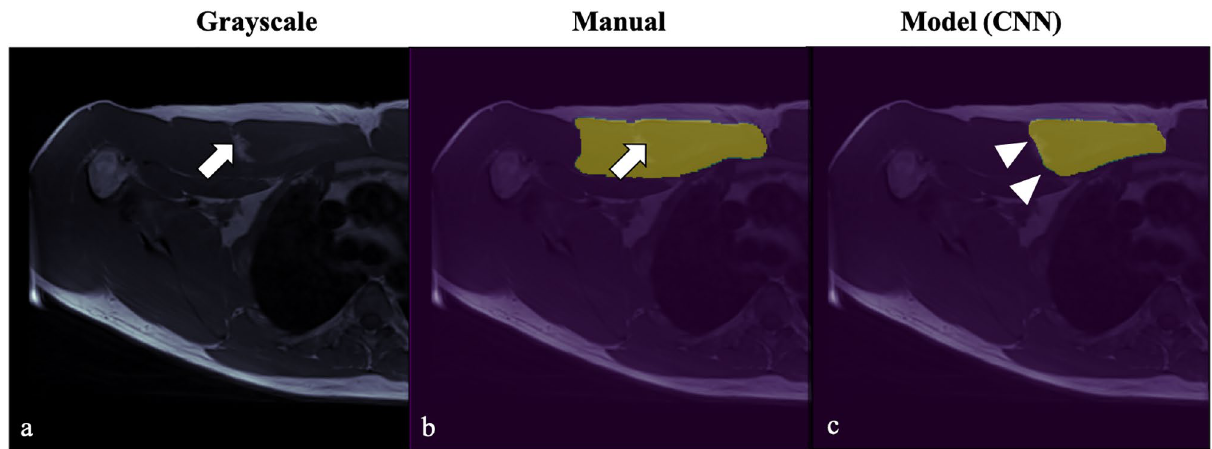
Figure 5. Prediction error on test images. Segmentation error at the lateral contour of the PM muscle (white arrow), due to focal fatty atrophy at the center of the muscle belly. ( a ) Grayscale Axial T1 FSE image, ( b ) manual tracing, and ( c ) CNN model prediction with underestimation of the PM muscle segmentation